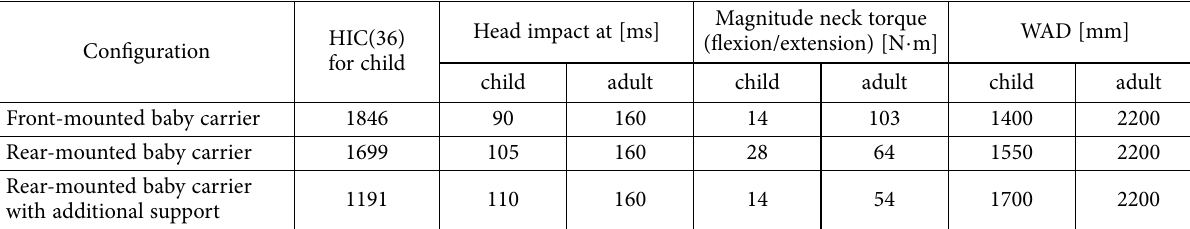
Table. Calculated characteristic head impact